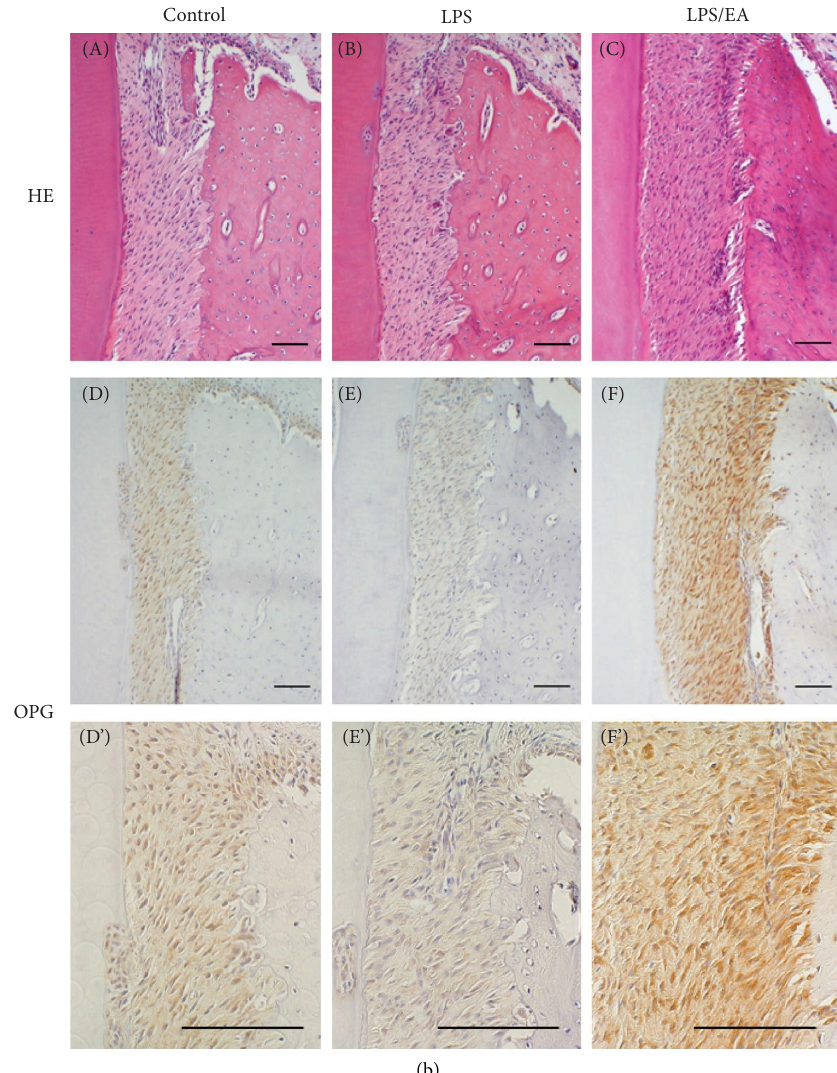
Figure 2: Immunohistochemical examination of periodontal tissue. (a) Hematoxylin and eosin (H&E) staining of tissue obtained from animals 3 days after Escherichia coli ( E. coli )-lipopolysaccharide (LPS) topical administration. (A) Control (PS-applied control), (B) E . coli - LPS, (C) E . coli -LPS/ Equisetum arvense extract (EA) application. Immunoexpression of the receptor activator of NF- κ B ligand (RANKL) in the upper part of the alveolar bone area, (D, D ′ ) control, (E, E ′ ) E . coli -LPS, and (F, F ′ ) E . coli -LPS/EA application. Scale bars � 100 μ m. (b) H&E staining of tissue obtained from animals 3 days after E . coli -LPS topical administration. (A) Control, (B) E . coli -LPS, and (C) E . coli - LPS/EA application. Immunoexpression of osteoprotegerin (OPG) in the upper part of the alveolar bone area, (D, D ′ ) control, (E, E ′ ) E . coli - LPS, and (F, F ′ ) E . coli -LPS/EA application. Scale bars � 100 μ